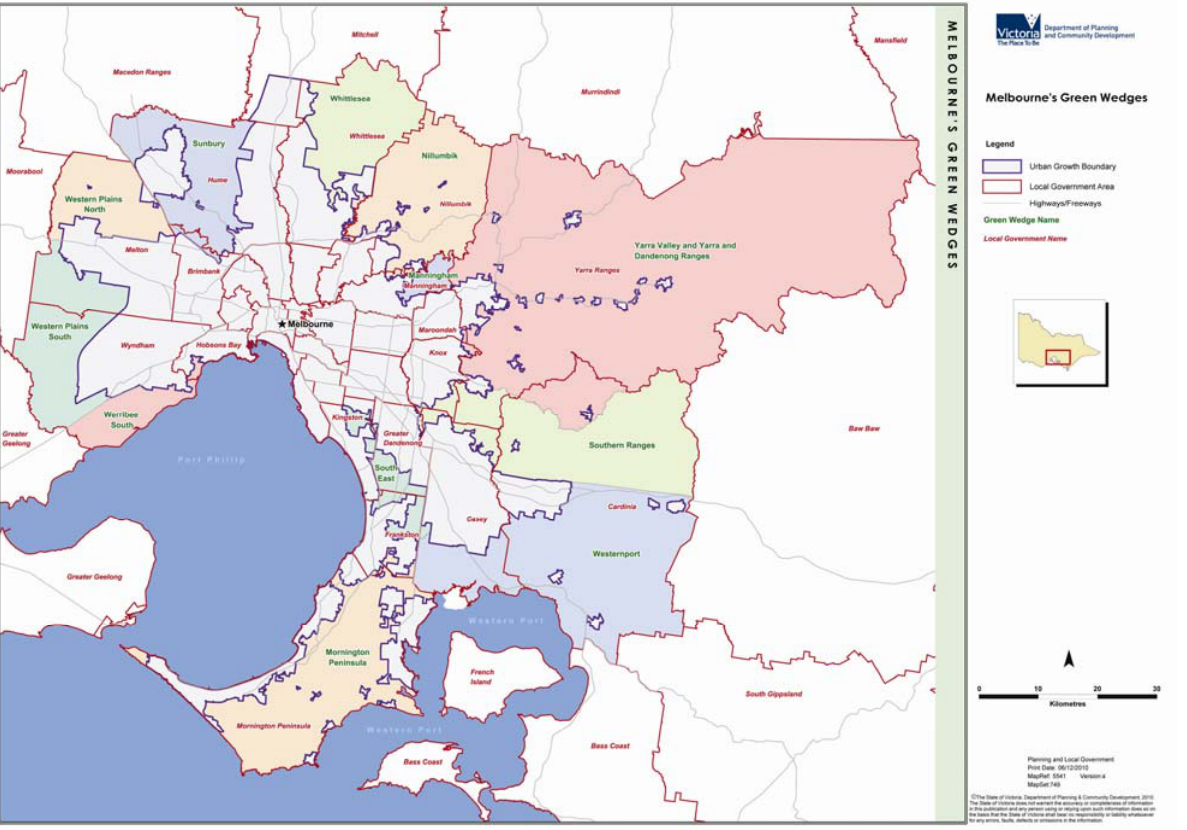
Figure 2. Melbourne’s Green Wedges. In mid-2010, Melbourne’s Urban Growth Boundary was expanded, adding another 43,600 hectares. This expansion overlaps with some green wedge